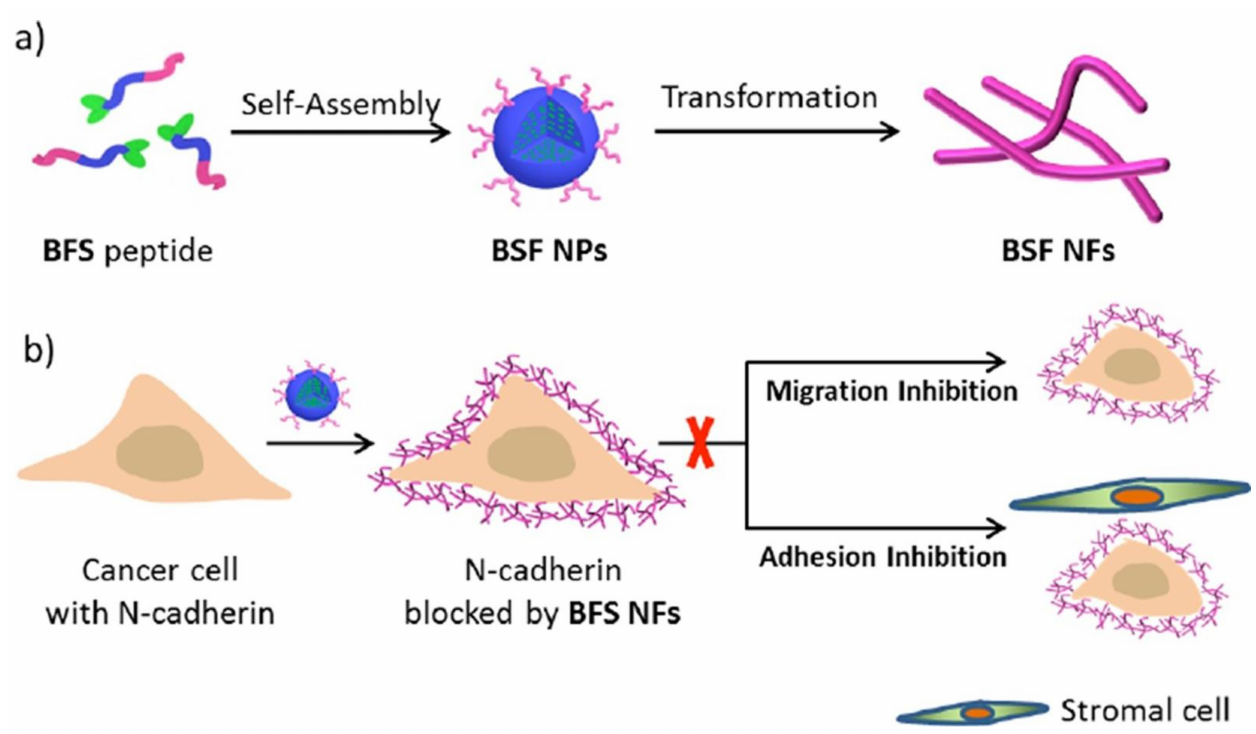
Figure 3. Schematic illustration of construction of peptide networks from transformable peptide nanoparticles by binding N-cadherin to inhibit migration and adhesion of cancer cells. ( a ) The peptide self-assembly into nanoparticles and transform into nanofibers upon binding N-cadherin. ( b ) The in situ construction of the peptide on N-cadherin cell surfaces to inhibit the adhesion and migration. Reproduced with permission from [67], Elsevier,